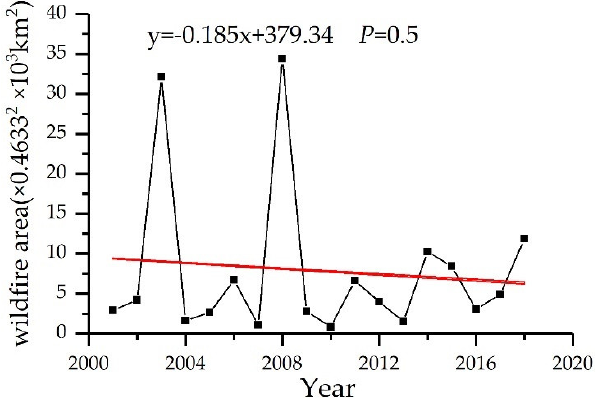
Figure 2. Interannual variation in spring wildfires (SWFs) area during the period of 2001–2018.